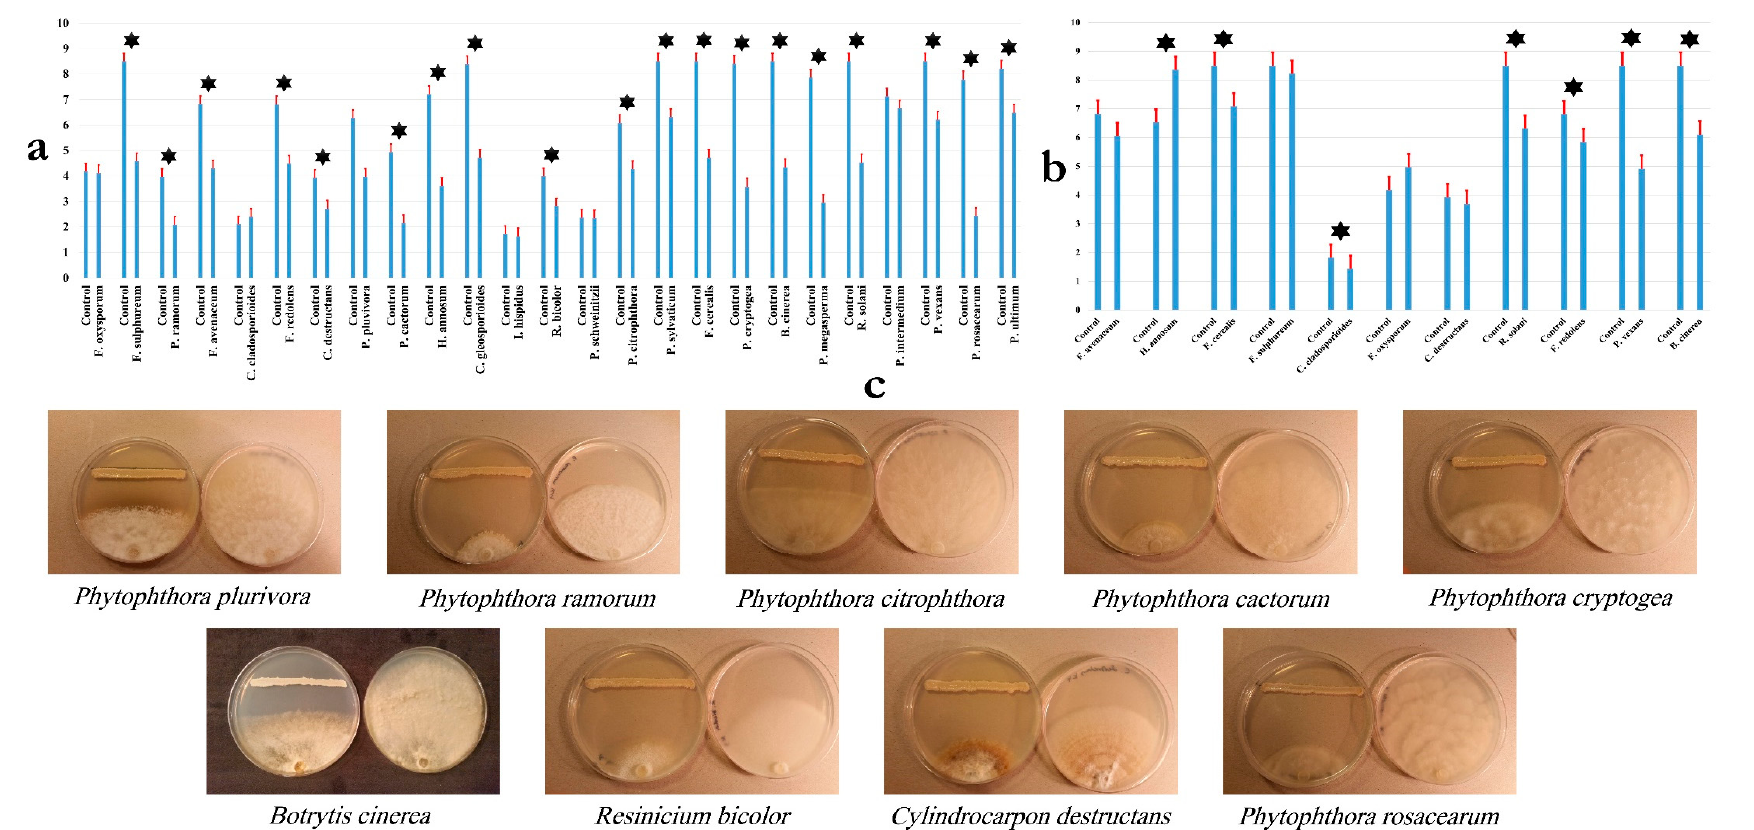
Figure 1. ( a,b ) Inhibition of Bacillus velezensis OEE1 against fungal species. Data presented as mean ± standard error. Bars labelled with the asterisks are significantly different from control according to Tukey’s HSD at p < 0.05. ( c ) Confrontation assay of antifungal activity of the bacterial isolate OEE1 against different fungal species. A representative control petri dish of each fungal species is presented.